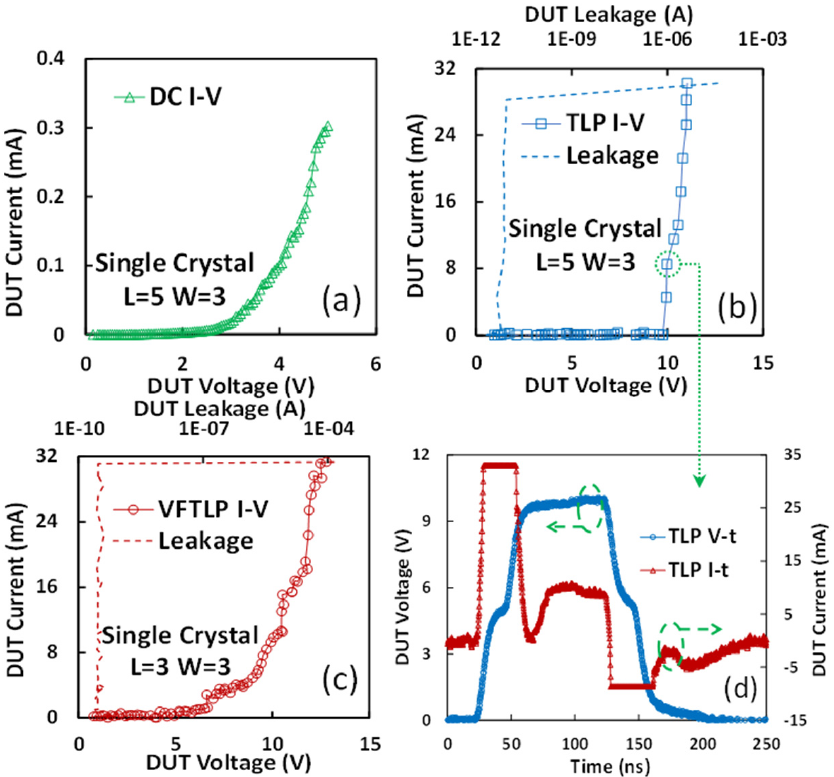
Figure 12. Measured switching I–V behaviors for different gNEMS devices using different test methods: ( a ) DC sweeping; ( b ) TLP stress for the HBM ESD model; ( c ) VFTLP stress for the CDM ESD model; ( d ) ESD I–V waveforms in the t-domain under TLP testing.